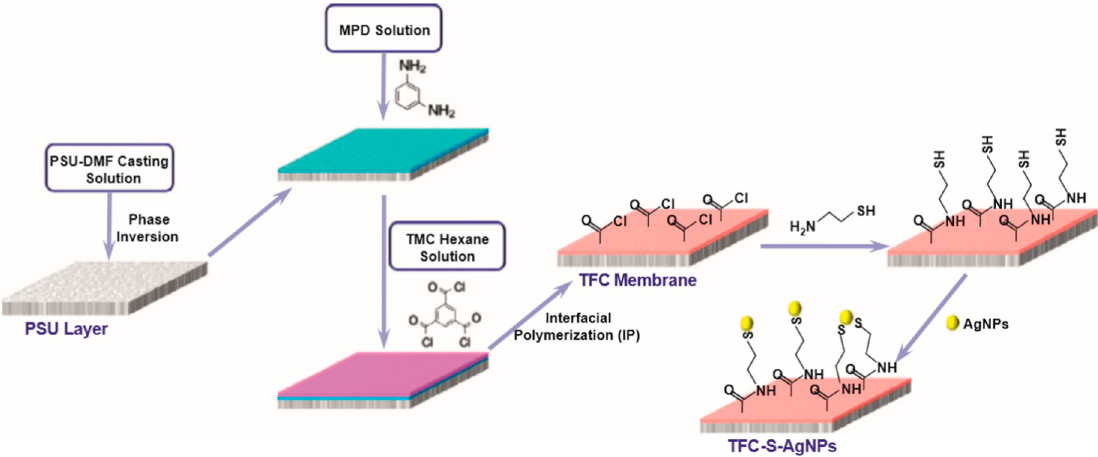
Figure 6. Schematic illustration of attaching Ag-NPs on the TFC membrane surface; reproduced with permission from Yin et al. [122], with copyright permission from © 2013 Elsevier.